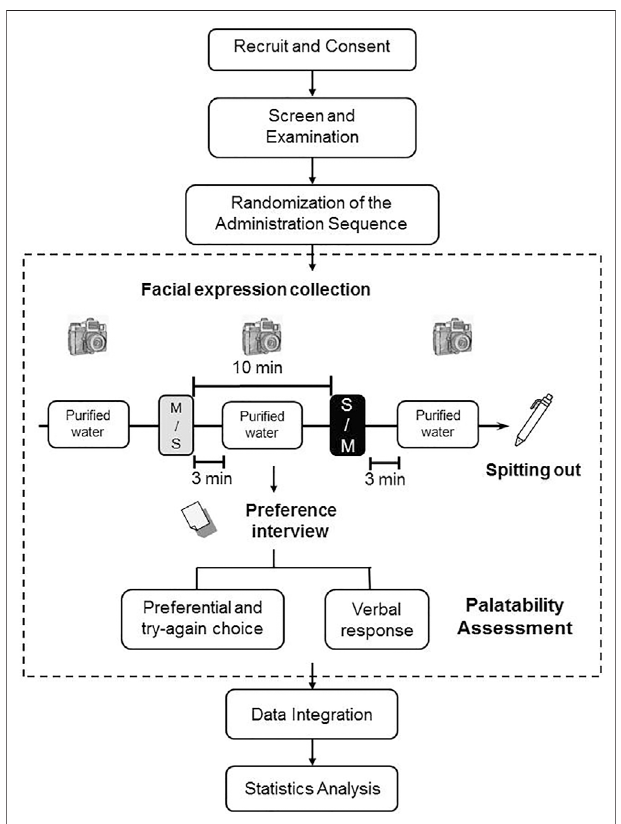
FIGURE 2 | Flowchart of this study.